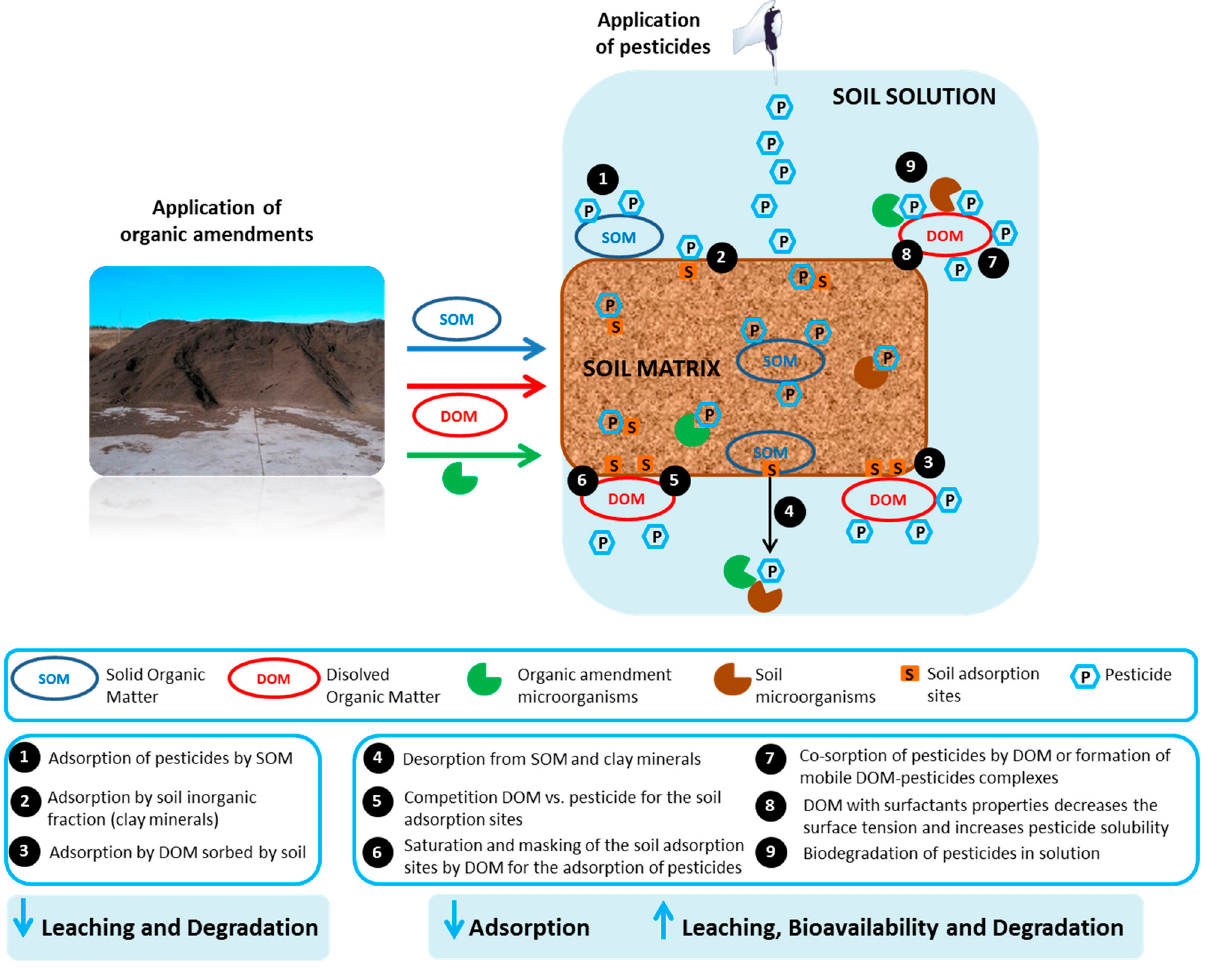
Figure 1. Summary of the organic amendments’ (solid organic matter (SOM) and dissolved organic matter (DOM)) effects on the processes controlling the fate of pesticides in soil.